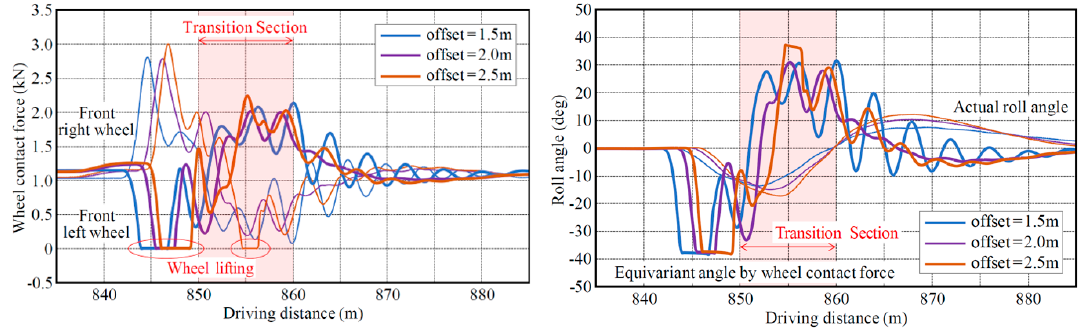
Figure 26. Lateral load transference and equivariant roll angle on load transference.